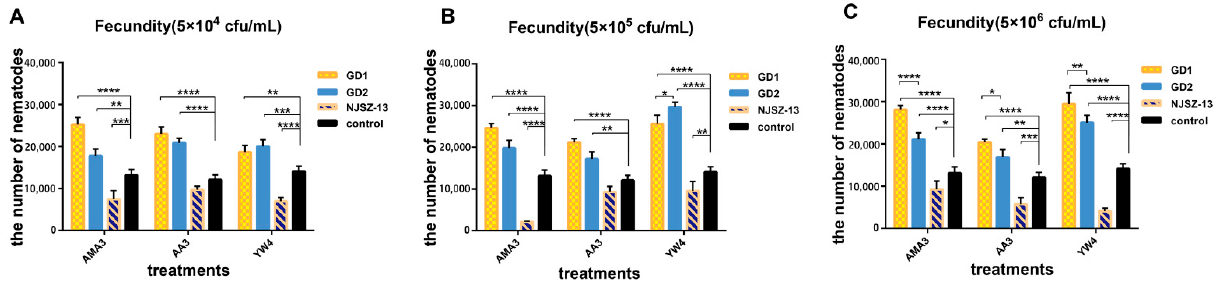
Figure 2. E ff ect of di ff erent concentrations of bacteria on the fecundity of pine wood nematodes Figure 2. Effect of different concentrations of bacteria on the fecundity of pine wood nematodes (PWNs). ( A ) Fecundity of different PWNs treated with 5 × 10 4 CFU/mL bacteria. ( B ) Fecundity of different PWNs treated with 5 × 10 5 CFU/mL bacteria. ( C ) Fecundity of different PWNs treated with 5 × 10 6 CFU/mL bacteria. All data are presented as the means ± SEM. All of the results were